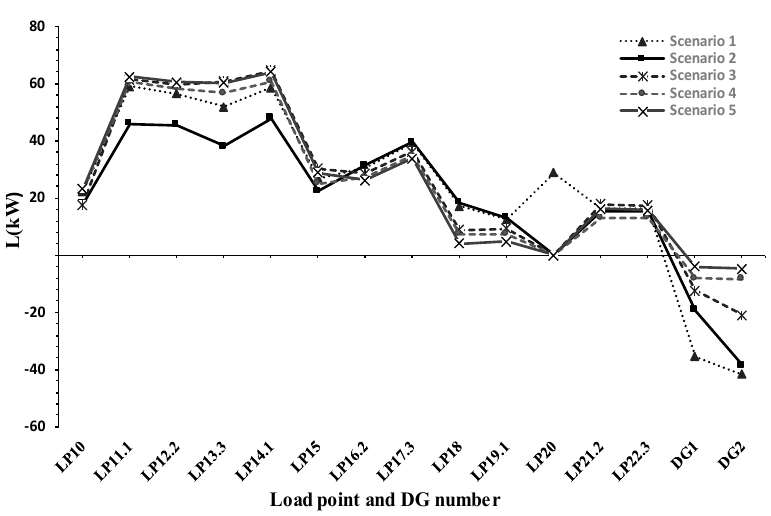
Figure 9. Allocated losses for different capacities of DGs.